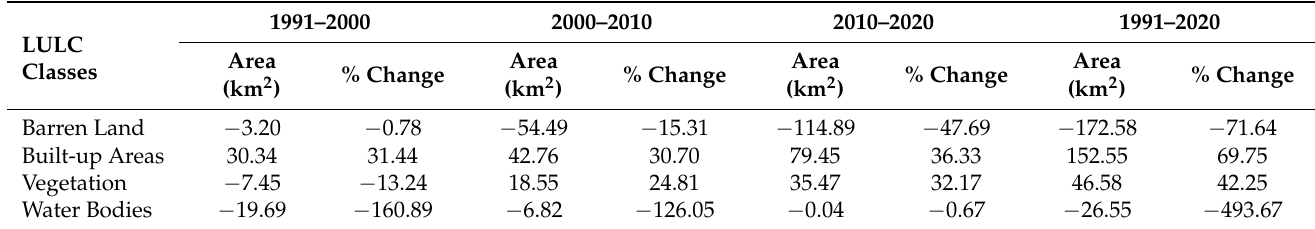
Table 6. Decadal Net Changes of LULC classes.